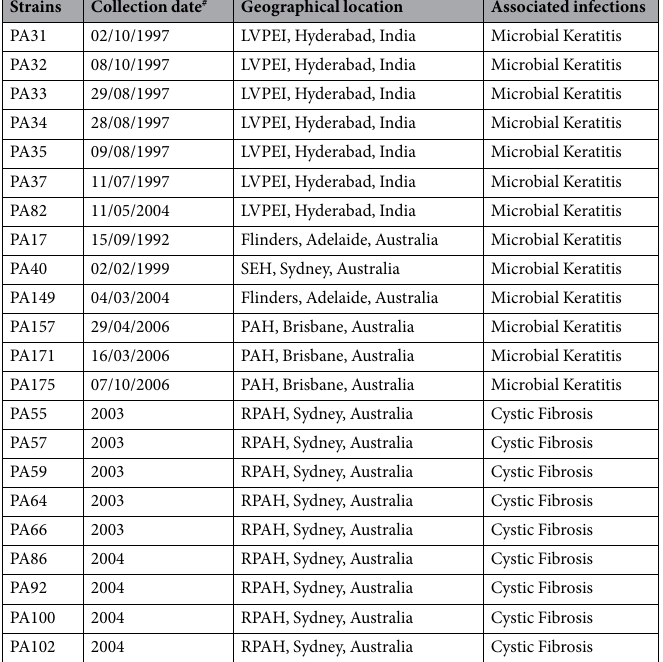
Whole genome sequencing.